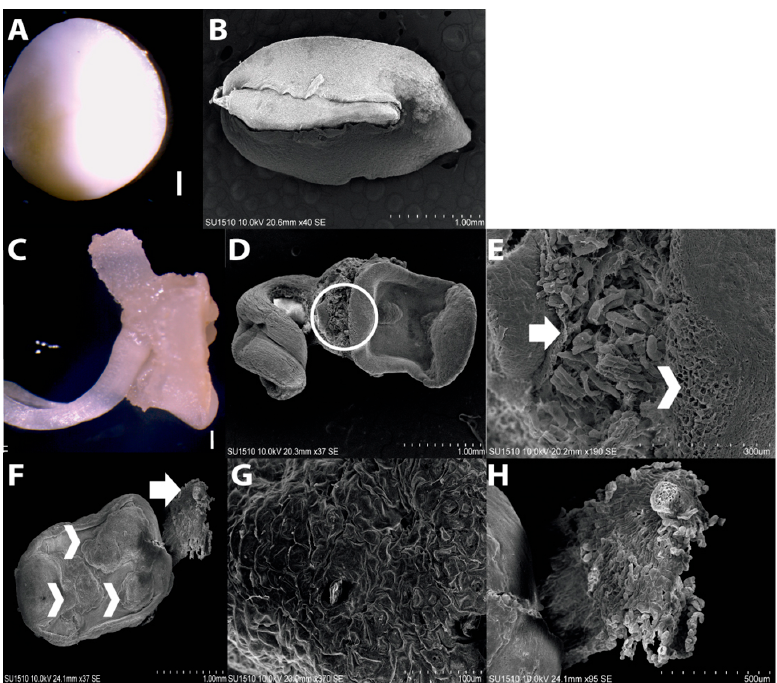
Figure 1. Origin of the different callus types for Tuxpeño VS-535. ( A ) Immature embryo (IE) at 15–18 days after pollination (DAP). ( B ) The IE observed with SEM. The embryonic axis and surrounding tissue are clearly distinguished. ( C ) The IE after seven days on N6I medium. Radicle protrusion and callus formation around the embryo are observed. ( D ) The IE after seven days on N6I medium observed with SEM. ( E ) Magnification of the circled area in D . The arrow points at non-embryogenic callus formation, whereas the arrowhead indicates pro-embryogenic callus tissue. ( F ) The IE after nine days on N6I medium observed with SEM. Cumulus of embryogenic masses formed on the scutellar epithelium are highlighted by several arrowheads, whereas an arrow points at non-embryogenic callus formed on the embryonic axis side. ( G ) Magnification of F in an arrowhead zone, ( H ) Magnification of G in the arrow zone.